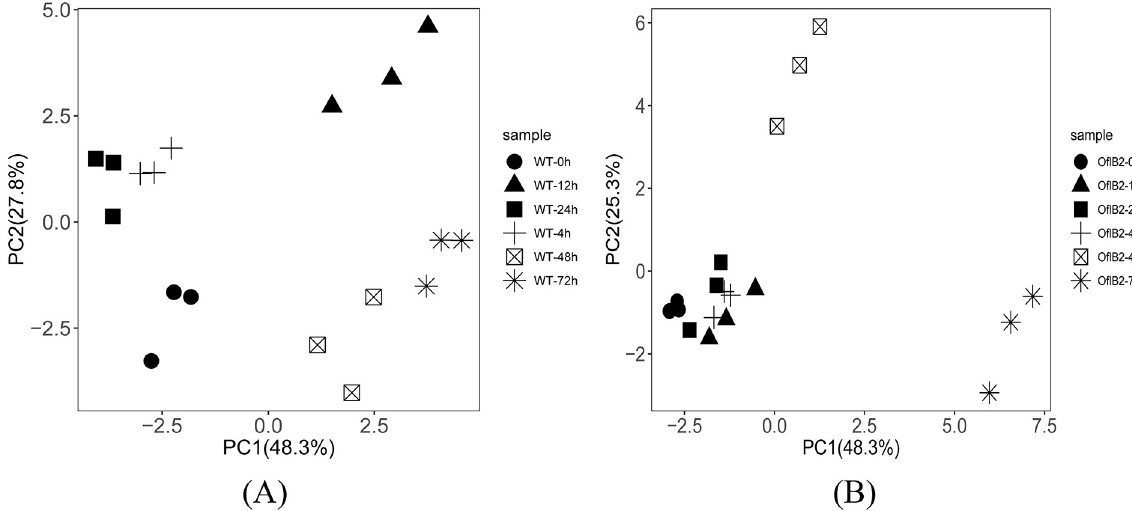
Fig 3. PCA analysis of WT E . gracilis (a) and OflB2 (b) against light